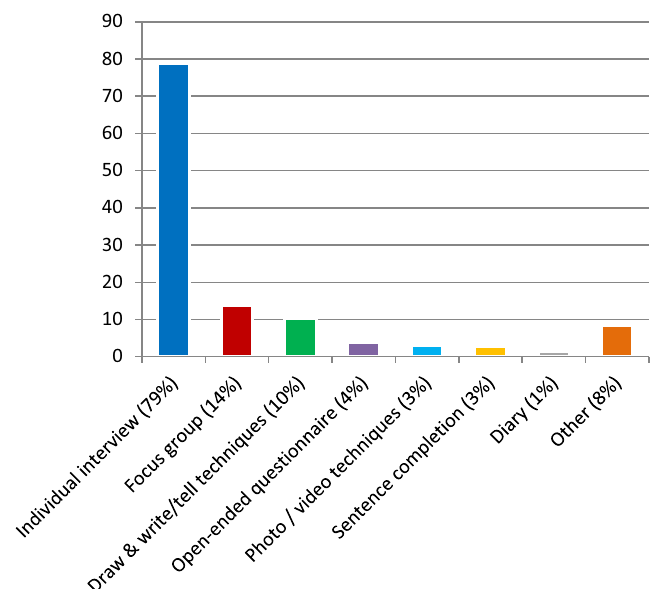
Fig. 4 Overview of the methods used for pediatric patient engagement in the included